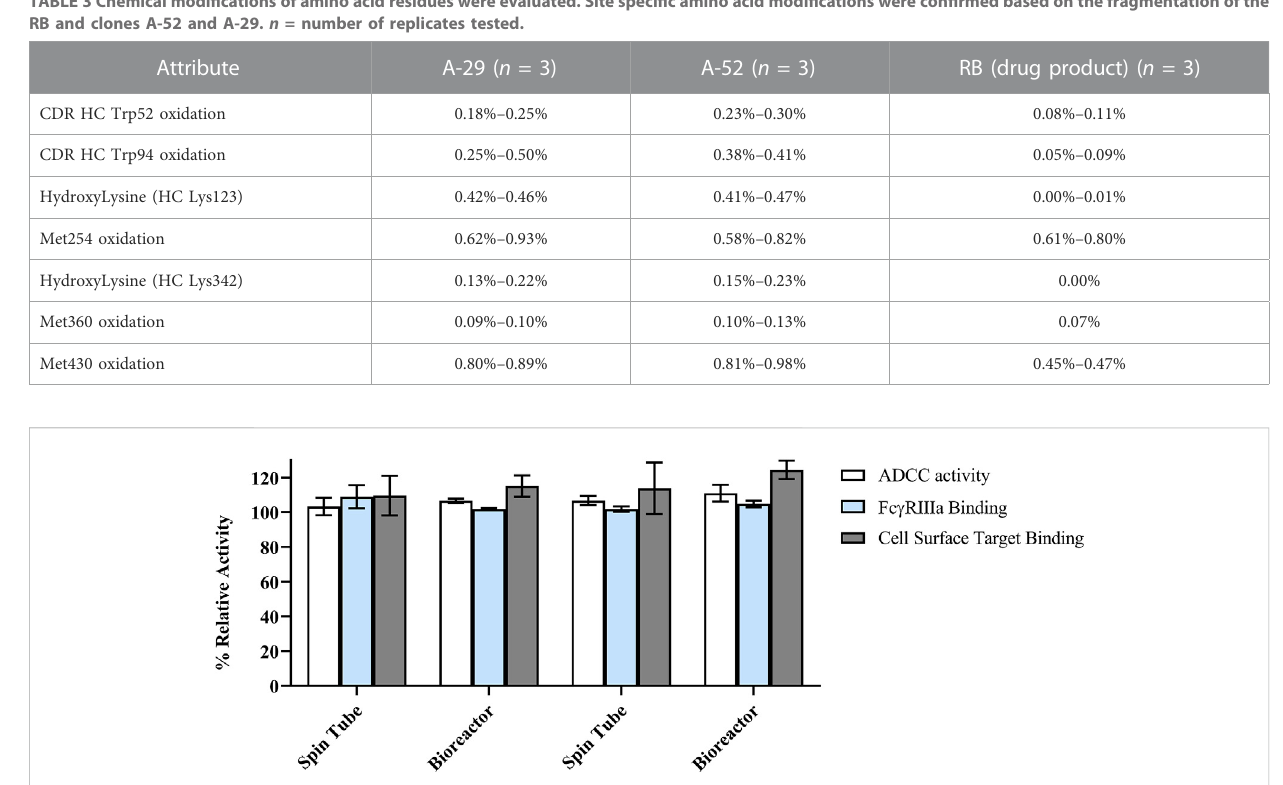
FIGURE 9 Summary of binding and biological activity of antibodies produced from clones A-29, and A-52 as compared to the reference biologic (RB). ADCC (antibody-dependent cell-mediated cytotoxicity), Fc γ RIIIa binding activity, and cell surface target binding. Relative activity (%) was calculated against RB reference standard lot. All samples were tested in triplicate for each assay, with the mean values reported as relative activity. The error bars represent the standard deviation calculated from data obtained in independent activity runs ( n =